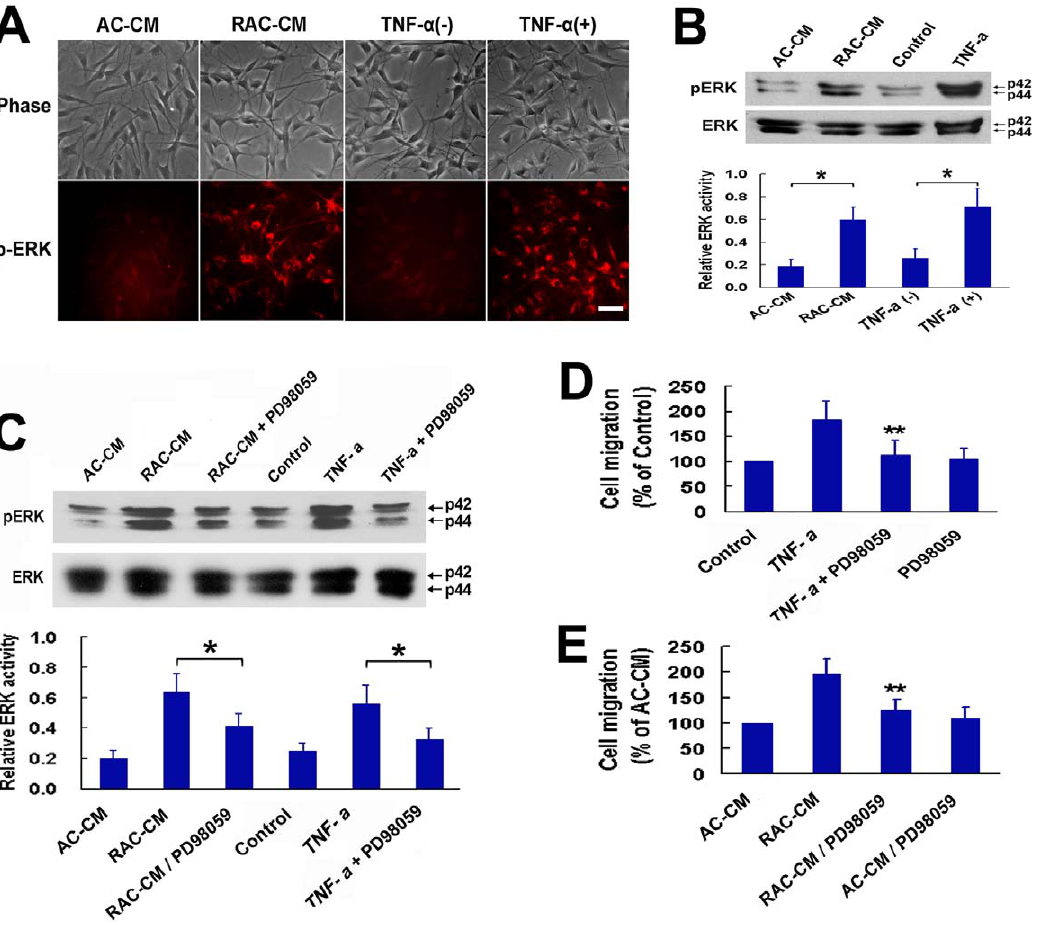
Figure 5. ERK activation is critical for mediating the effect of TNF- a on OECs migration. (A, B) ERK activation in OECs was assessed with immunocytochemistry (A) and western blot (B) after incubation with RAC-CM or recombinant TNF- a . Densitometric analysis is shown in the bottom panel of (B) with the amount of p-ERK normalized to the amount of ERK. * P , 0.05. Scale bar=50 m m. (C) PD98059 treatment significantly inhibited the activation of ERK in OECs stimulated with RAC-CM or recombinant TNF- a . OECs were incubated with ERK-inhibitor PD98059 (30 m M) for 30 minutes before RAC-CM or TNF-a (50 ng/mL) was added. Densitometric analysis is shown in the bottom panel. * P , 0.05. (D, E) In Boyden chamber migration assay, the migration induced by RAC-CM or recombinant TNF- a was evidently attenuated when OECs were pretreated with PD98059. ** P , 0.01 versus TNF- a or RAC-CM.